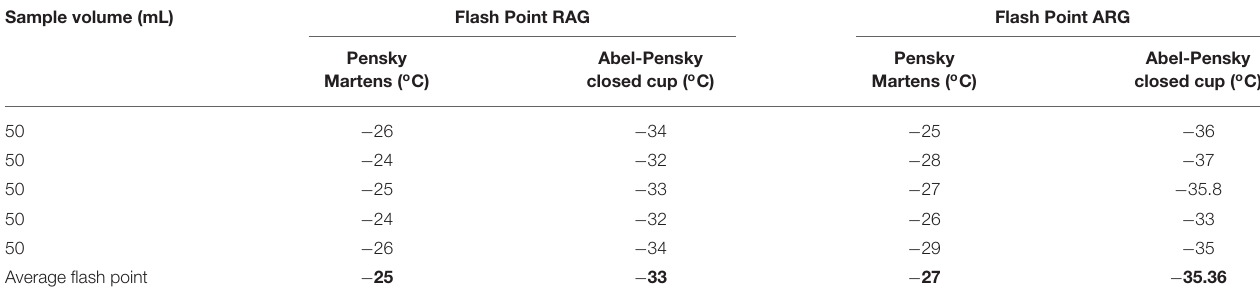
TABLE 6 | Flash point (Pensky Martens o C, Abel-Pensky closed cup o C) of RAG and ARG.